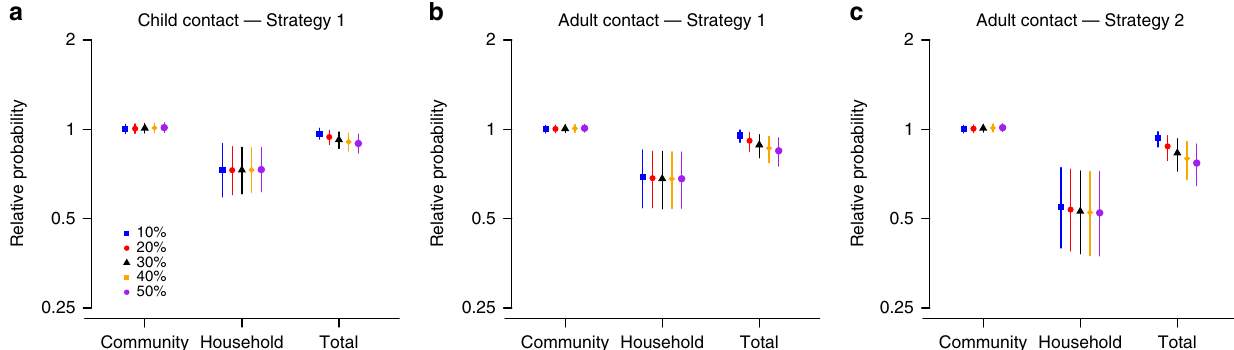
Community Household Fig. 5 The relative probability of infection for household contacts of vaccinated children, under two vaccination strategies compared with no vaccination strategy. The two strategies are 1: vaccination one child per household and strategy 2: vaccinating all children in the household. The relative probabilities are presented for infections from the community only (abbreviated as “ Community ” in x -axis), infections from household members only ( “ Household ” ), and all infections ( “ Total ” ). Results are presented for different assumptions about the proportion P of cases attributed to household transmission: 10% (blue), 20% (red), 30% (black), 40% (orange), and 50% (purple). Results for vaccination strategy 1 are presented in ( a and b ); those for strategy 2 in ( c ). 95% posterior predictive intervals are constructed with 10,000 simulated epidemics based on the estimated posterior distribution of model parameters (Supplementary